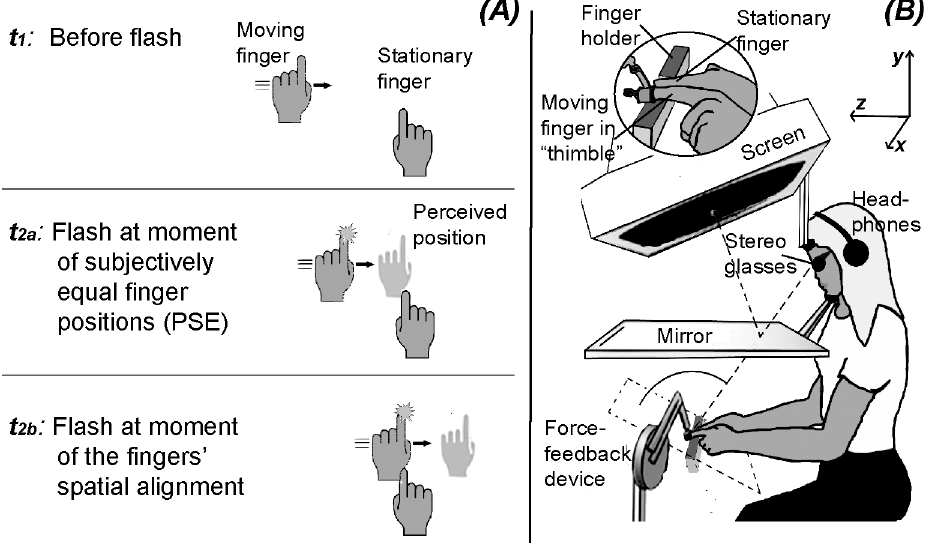
Fig 1. Haptic flash-lag effect and experimental setup. (A) A haptic flash-lageffect. One finger moves parallelto the transverse (x-) axis (t 1 ). Then, the “haptic flash” is applied.The two fingers are perceivedto be alignedduringthe flash, when the moving finger has not yet crossed the non-moving finger (t 2a ), but under spatialalignmentthe moving finger is perceivedto be ahead the non-moving one (t 2b ). (B) Visuo-hapticset- up; the inset shows the finger holderthat held the non-moving finger belowthe midpoint of the movement corridor. In the first experiment the moving finger was always the right index finger, in the second experiment both index fingers were used as moving finger in